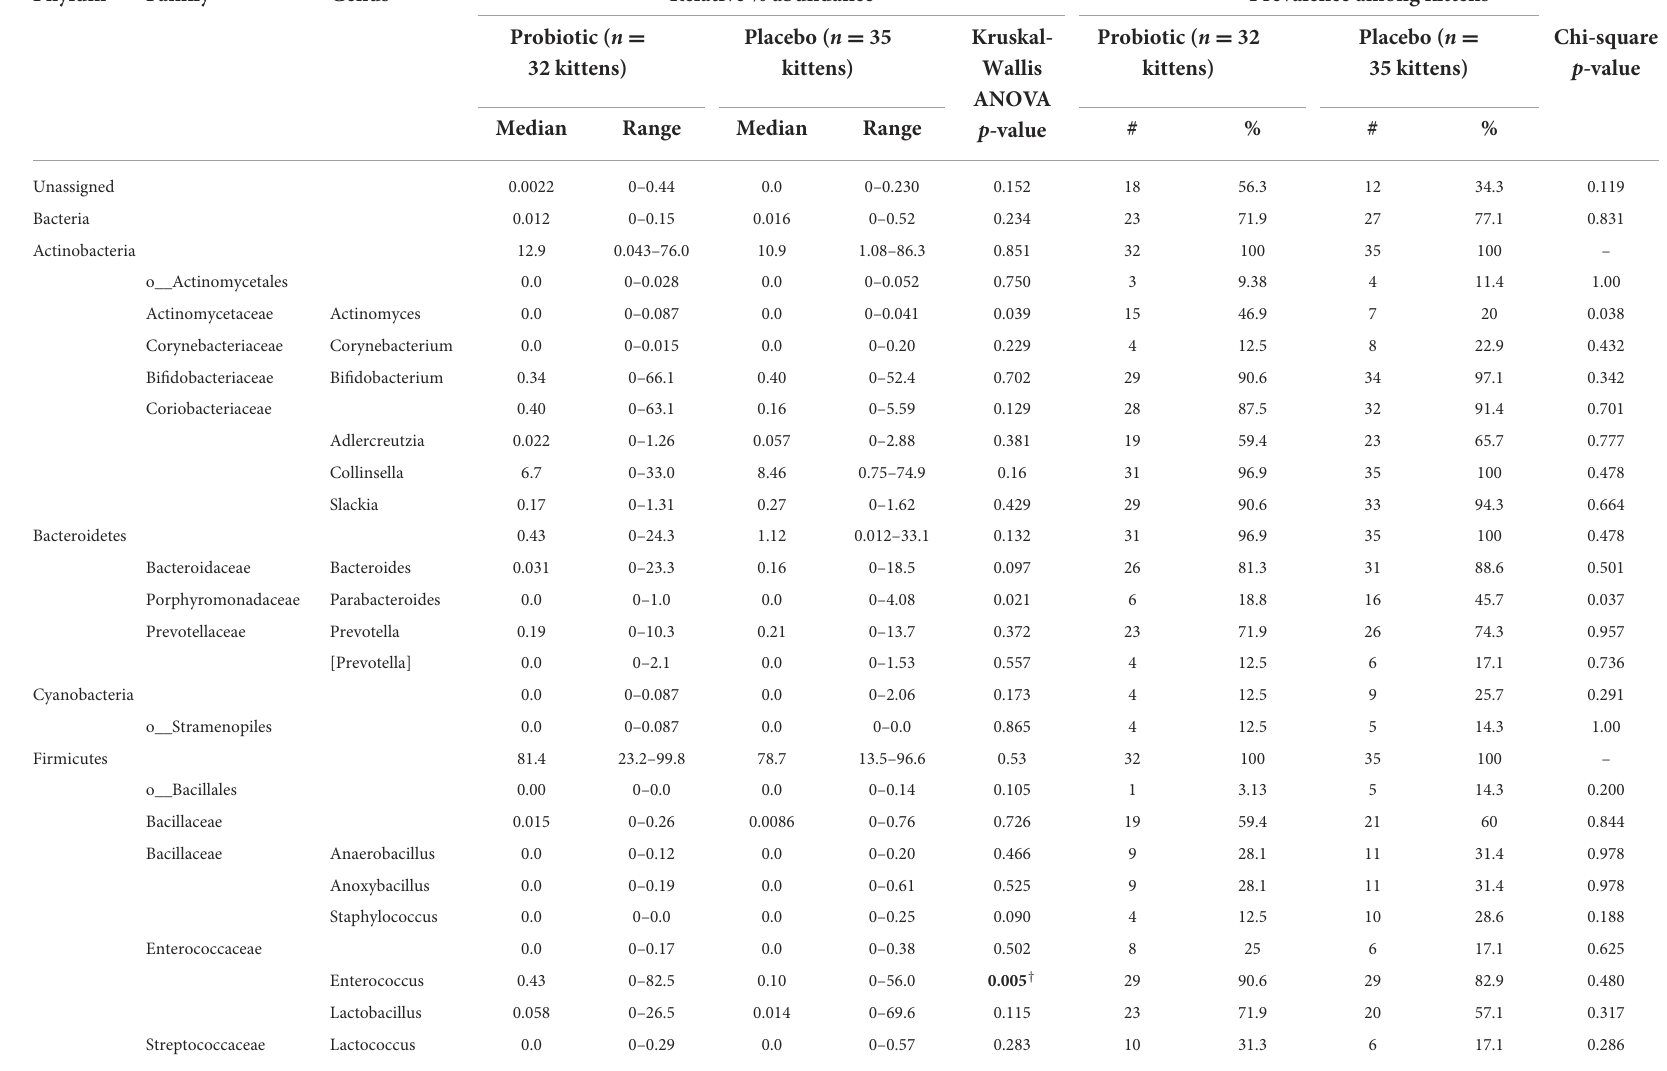
TABLE 4 Relative abundance and prevalence of taxa (percent of total sequences) observed by amplification and sequencing of 16S rDNA from feces of 67 kittens randomized to treatment with daily E. hirae probiotic (32 kittens) or placebo (35